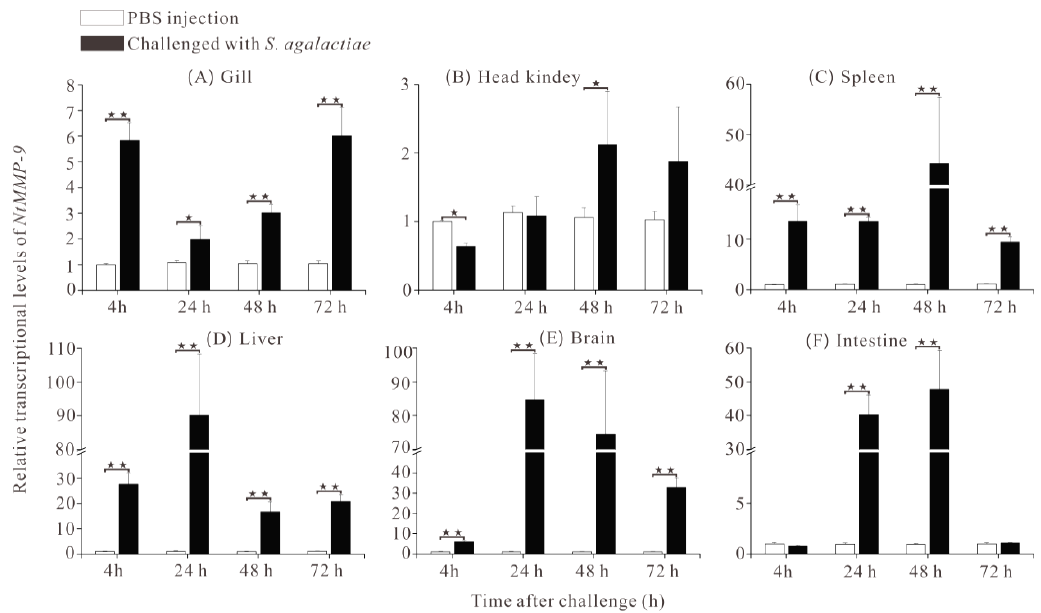
Figure 5. Relative transcriptional levels of NtMMP-9 at different time points in six tissues of Nile tilapia after the S. agalactiae challenge . Six tissues are gill ( A ), head kindey ( B ), spleen ( C ), liver ( D ), brain ( E ), intestine ( F ) in sequence. (* 0.01 < p < 0.05; and ** p < 0.01).